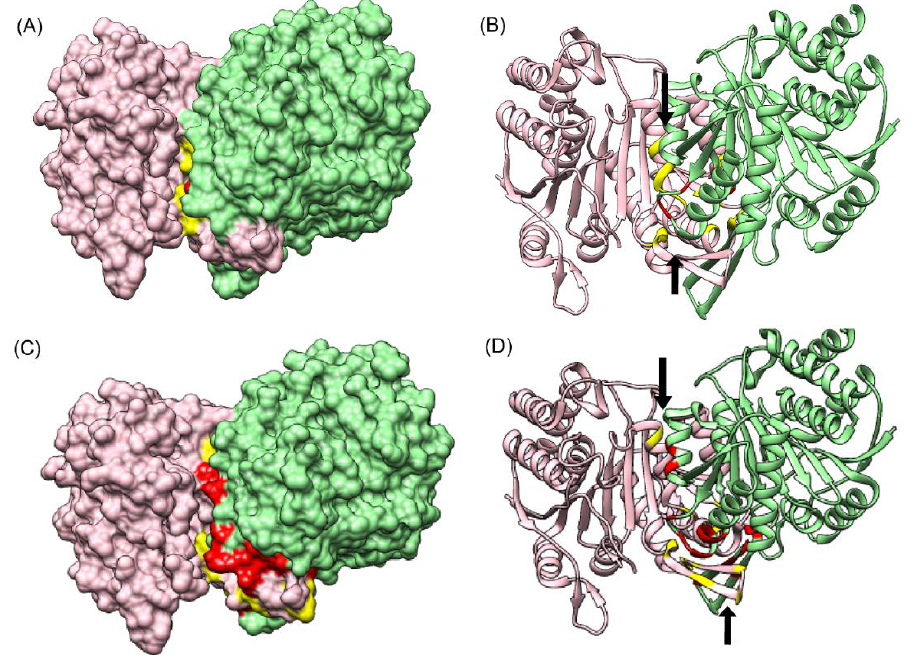
Figure 7. Comparison of CoRNeA with BIPSPI ( A ) Surface representation of 5YVT depicting interface residues predicted by BIPSPI. ( B ) Cartoon representation of interface residues predicted by BIPSPI. ( C ) Surface representation of 5YVT depicting interface residues predicted by CoRNeA. ( D ) Cartoon representation of interface residues predicted by CoRNeA. Chain A in pink and their respective interface residues are shown in yellow. Chain B in green and its interface residues are depicted in red. The black arrows indicate the regions of interface predicted by CoRNeA/BIPSPI.